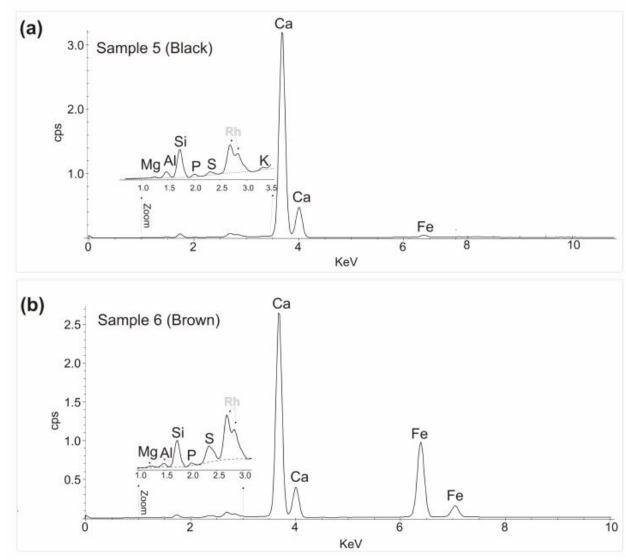
Figure 5. P-XRF spectra of the painted surfaces of Samples 5 ( a ) and 6 ( b ).